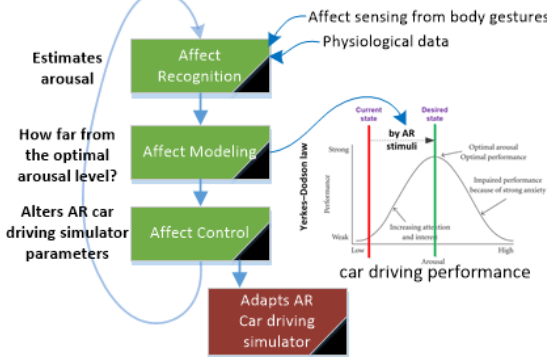
Figure 5. Closed-loop affective computing architec- ture for augmented